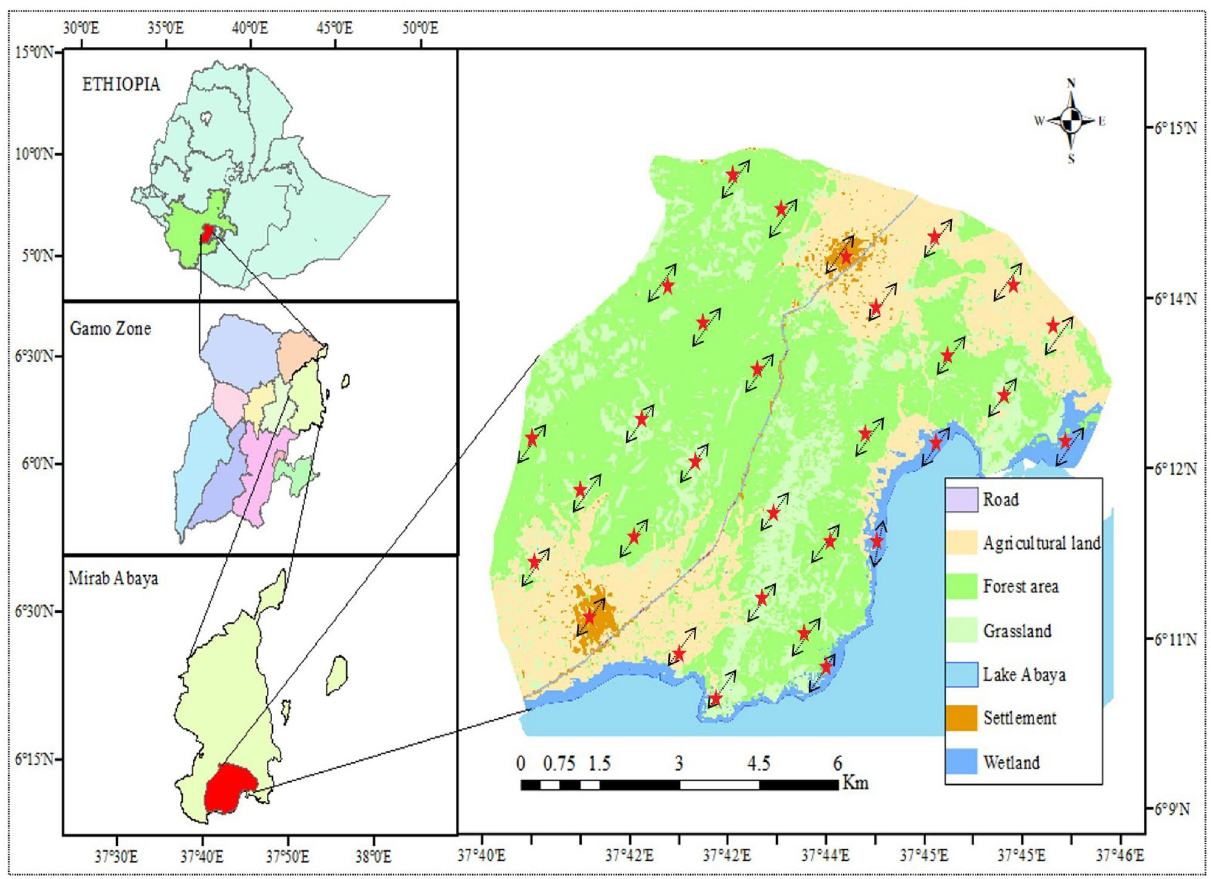
Fig. 1 Map of Faragosa-Fura Landscape showing land-use types, 30 transect lines (black arrows) and camera stations (red stars) in Southern Rift Valley,